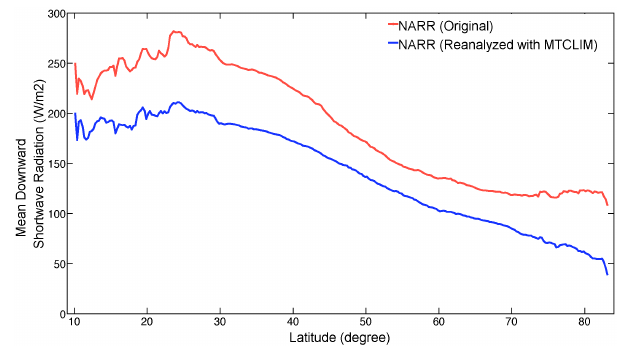
Figure 4. Comparison of the latitudinal zonal (0.25 ◦ ) mean of long- term mean downward shortwave radiation (1979–2010) on land sur- face from original NARR and reanalyzed NARR data